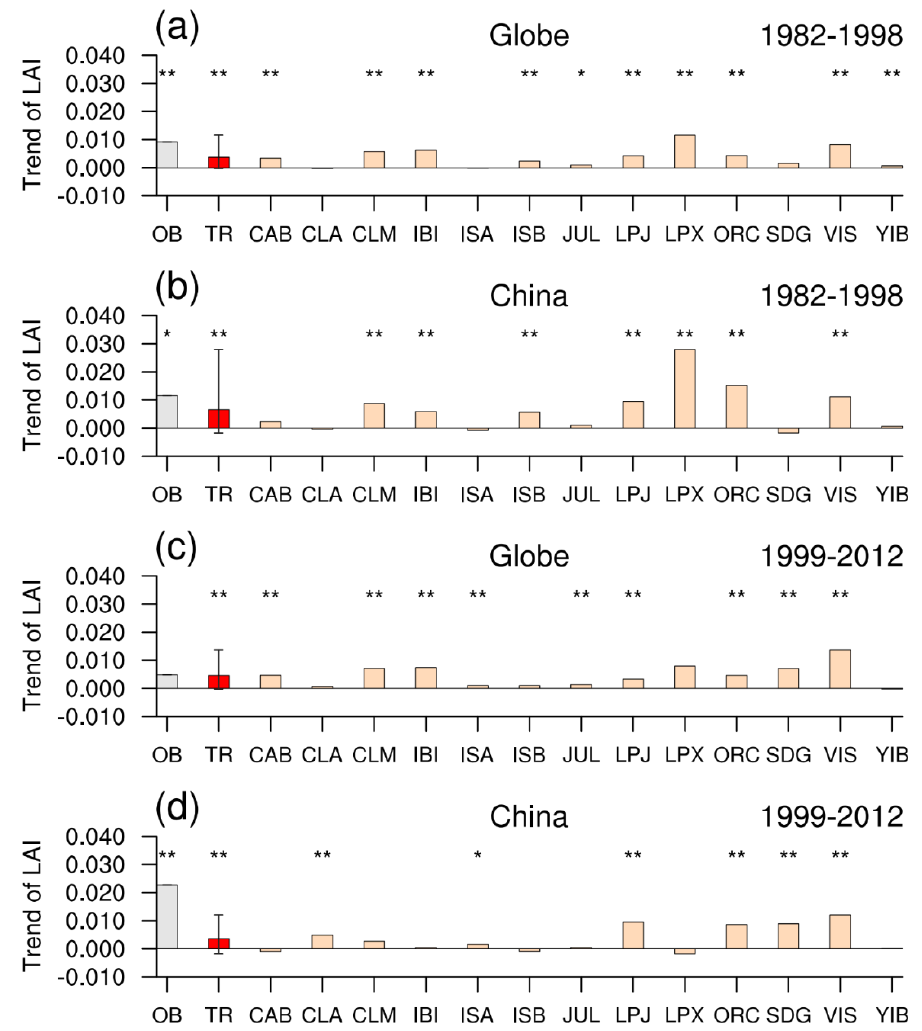
Figure 2. Trends of LAI for the ( a , c ) globe and ( b , d ) China during ( a , b ) the period of 1982 – 1998 and ( c , d ) 1999 – 2012, derived from satellite observation (OB) and 13 TRENDY models. TR means the average of the TRENDY models. Horizontal lines indicate ± σ . Two asterisks indicate that the trend is statistically significant ( p < 0.05) and one asterisk indicates statistical significance at the 0.1 level.